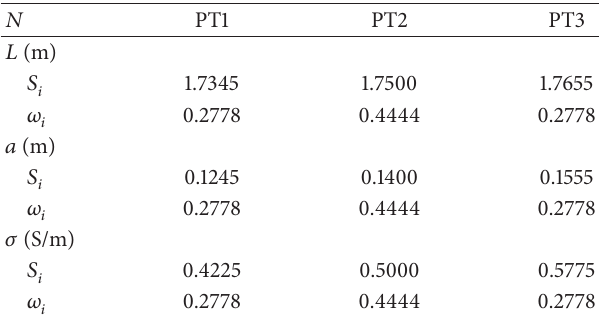
Figure 2: Induced axial current in the human body with conductiv- ity 𝜎 as RV: ⟨𝐼⟩ is stochastic expected value, 𝜎 𝐼 is standard deviation, and 𝐼 is the value obtained from numerical deterministic model. Table 3: Sigma-weight pairs for each of the random